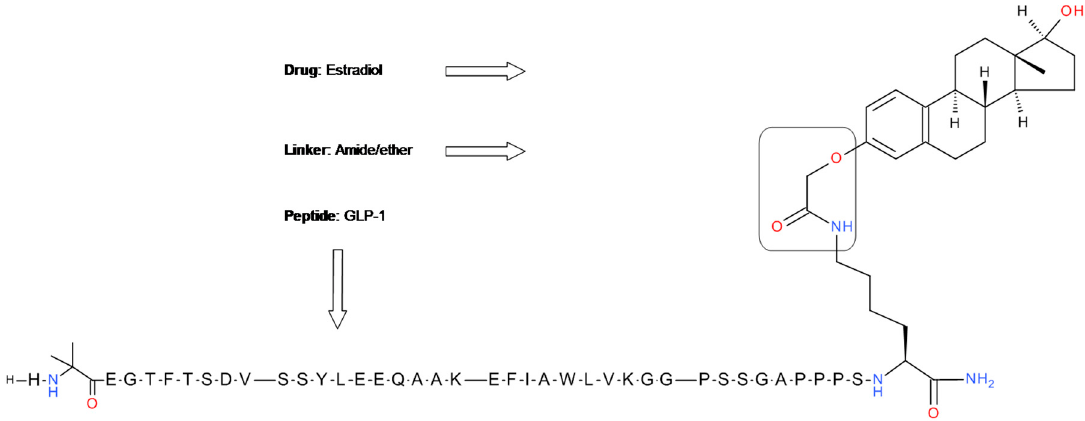
Figure 5. Chemical structure of GLP-1-estradiol conjugate.